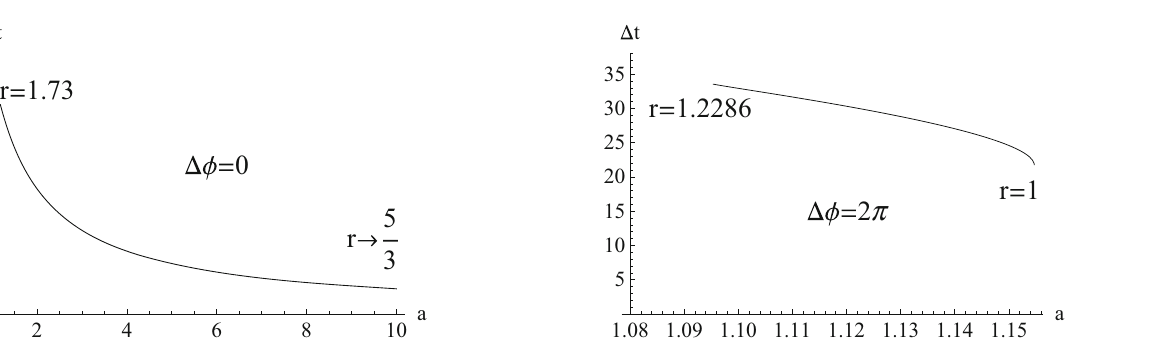
Fig. 22 Dependence of the period of the photon circulation over a closed spherical orbit with zero nodal shift on the spin parameter a . The graph is defined for a > 1 . 18 . Such orbits are of octal shape (see case k = 0 in Fig. 9)